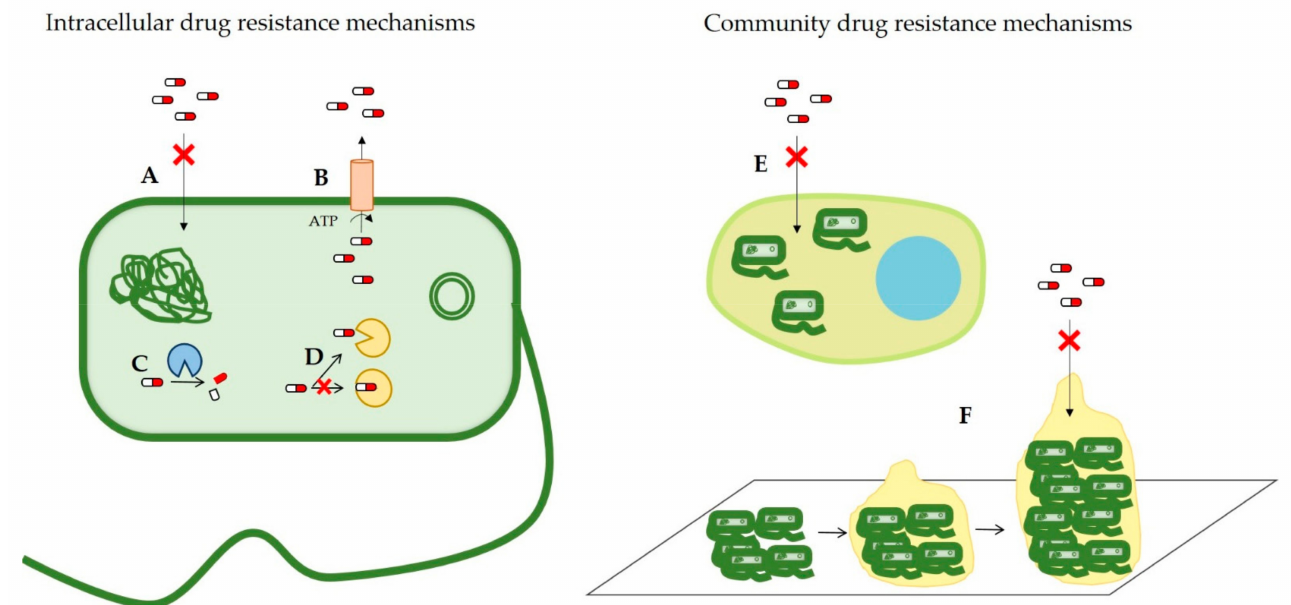
Figure 1. Schematic representation of the intracellular (left) or community (right) antibiotic resistance mechanisms. Intracellular antibiotic resistance mechanisms are ( A ) decreased cell wall permeability, ( B ) increased expression of efflux pumps, ( C ) expression of antimicrobial-modifying enzymes that deactivate antibiotic molecules and ( D ) modification of the antibiotic target. Community antibiotic resistance mechanisms are ( E ) intracellular infection or ( F )